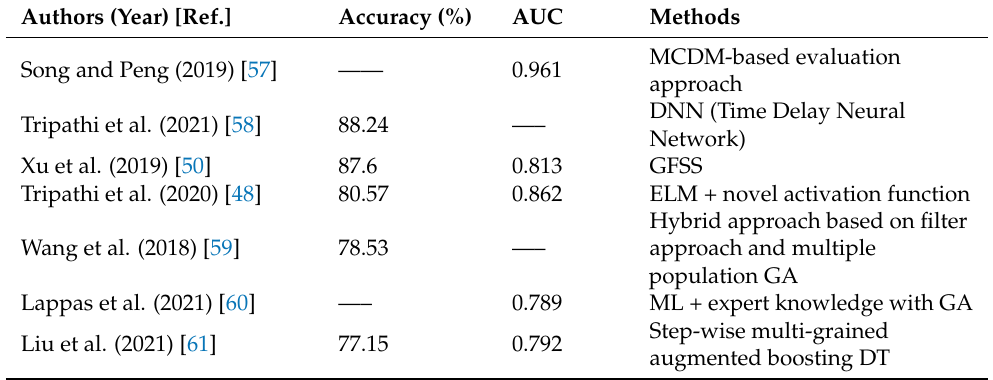
Table 4. Accuracy and area under the receiver operating characteristic curve (AUC) values of hybrid and ensemble classifiers for the German (numerical)